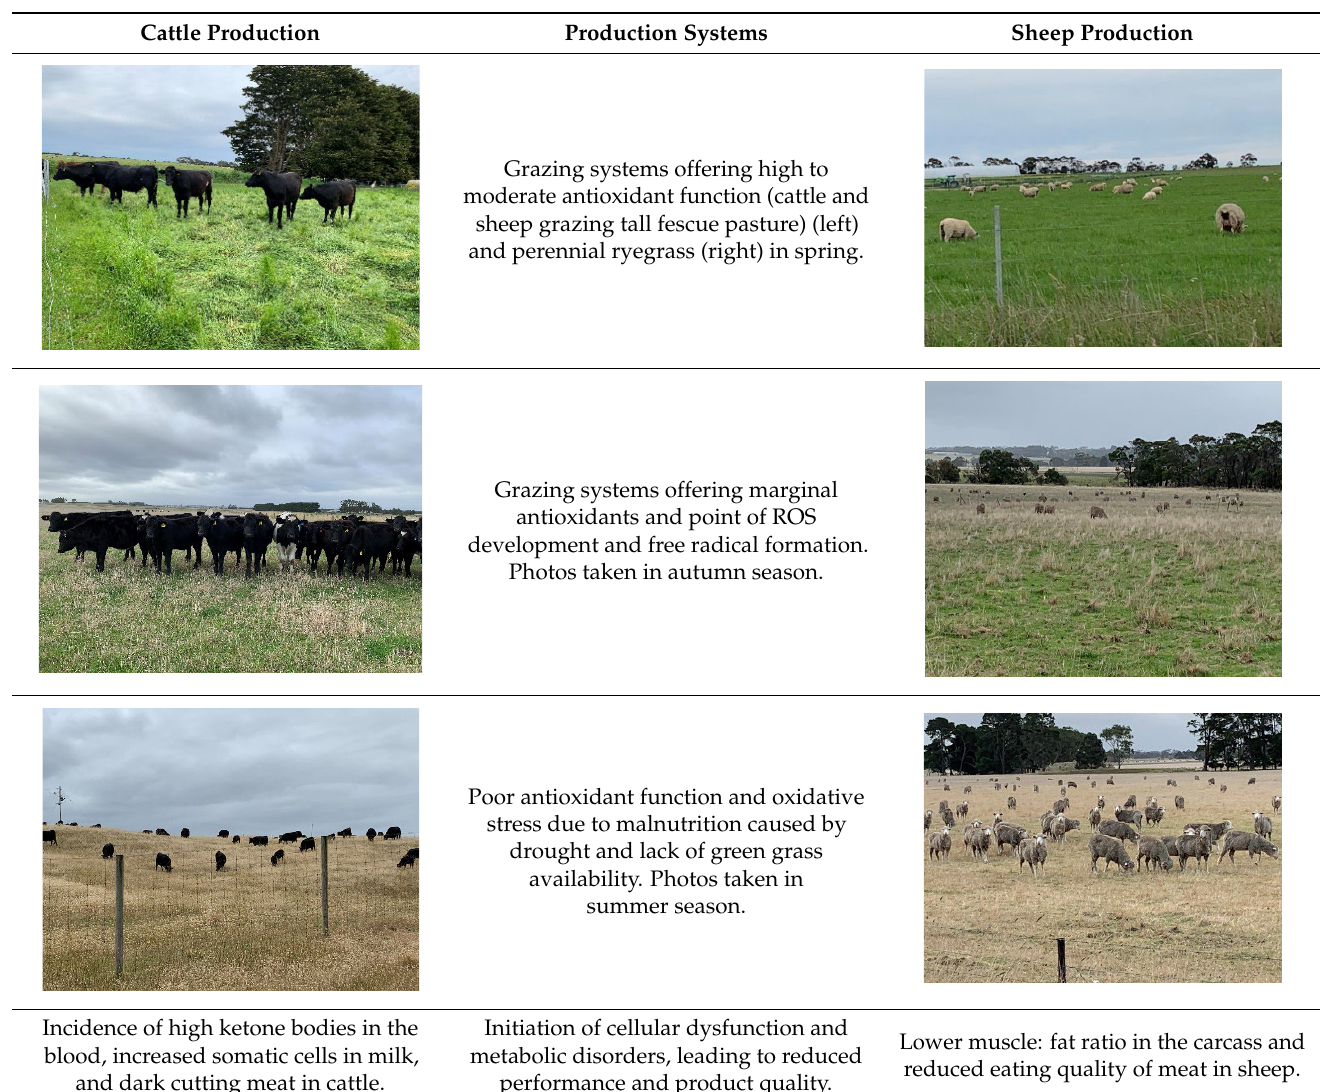
Lower muscle: fat ratio in the carcass and reduced eating quality of meat in